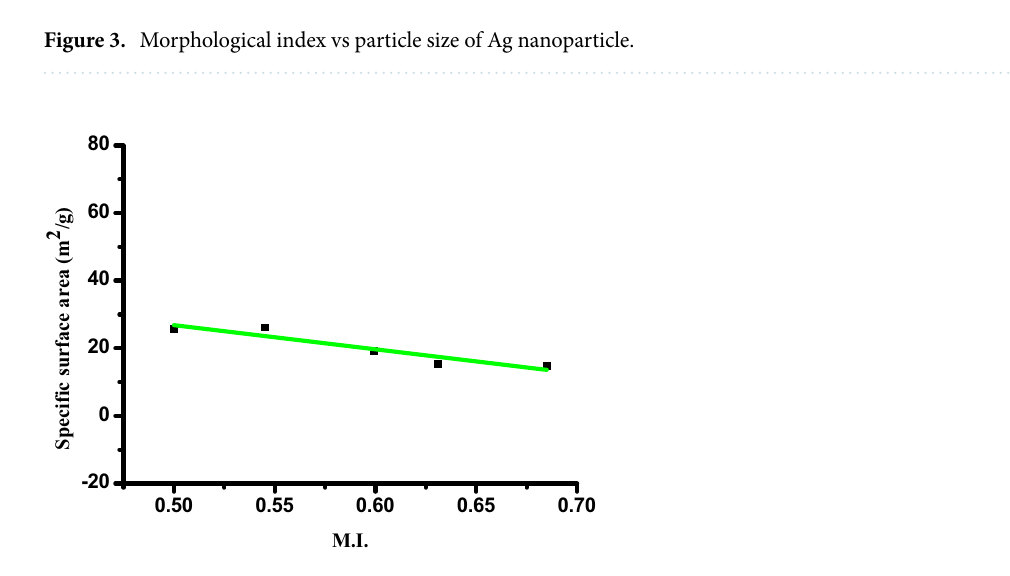
Figure 4. Morphological index vs specific surface area of Ag